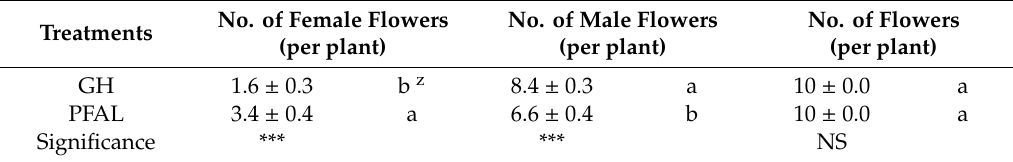
Table 8. Development of grafted cucumber seedlings after transplanting as affected by the cultivation of scions and rootstocks in a PFAL and GH ( n = 7, R = 3). Treatments